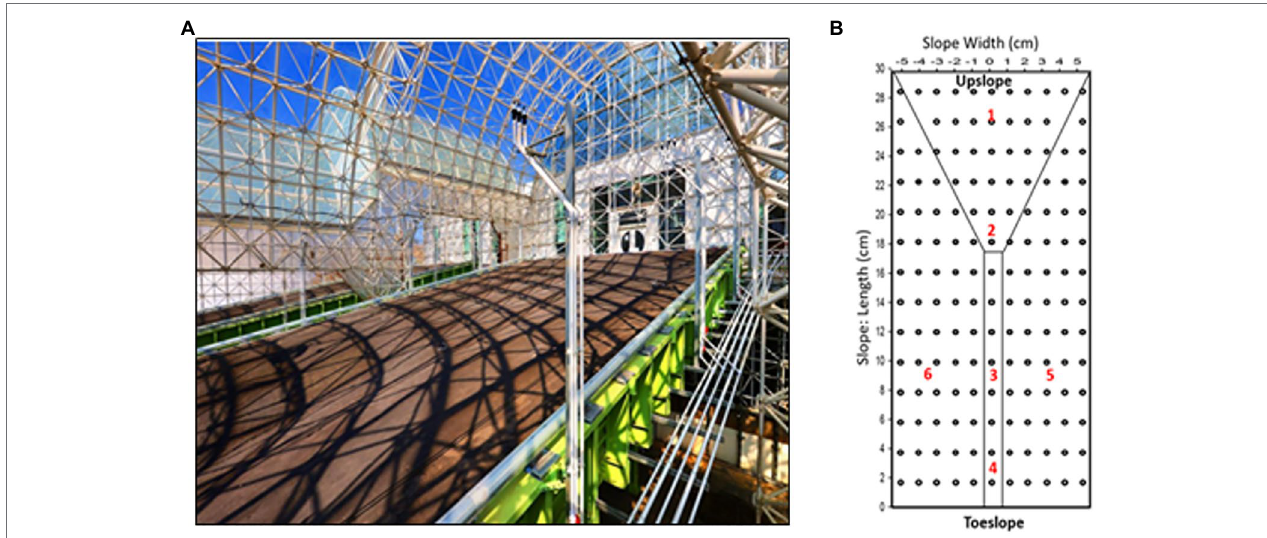
FIGURE 1 | Landscape evolution observatory (LEO; A ) upslope view of one of the hillslopes with (B) soil sampling locations (red numbers) and in situ moisture sensors